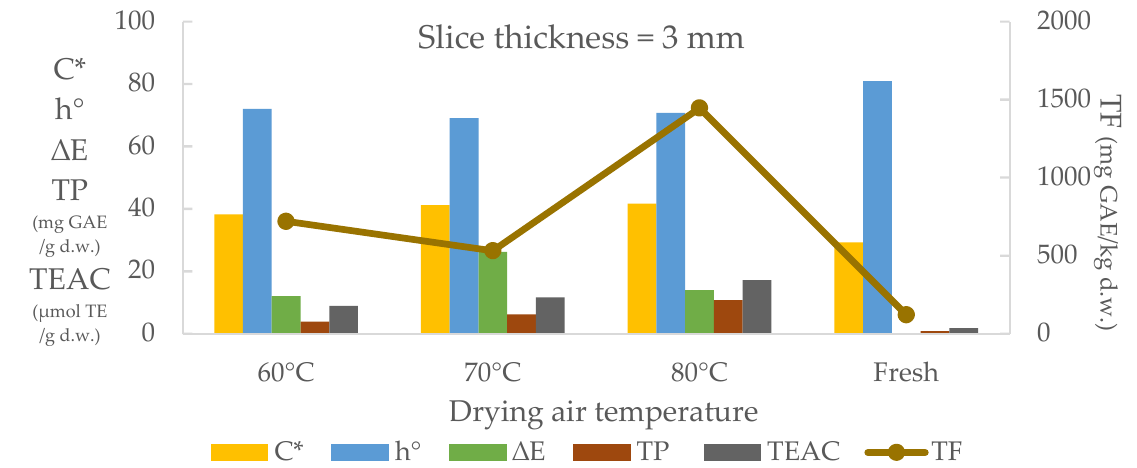
Figure 7. Effects of drying air temperature on quality parameters.